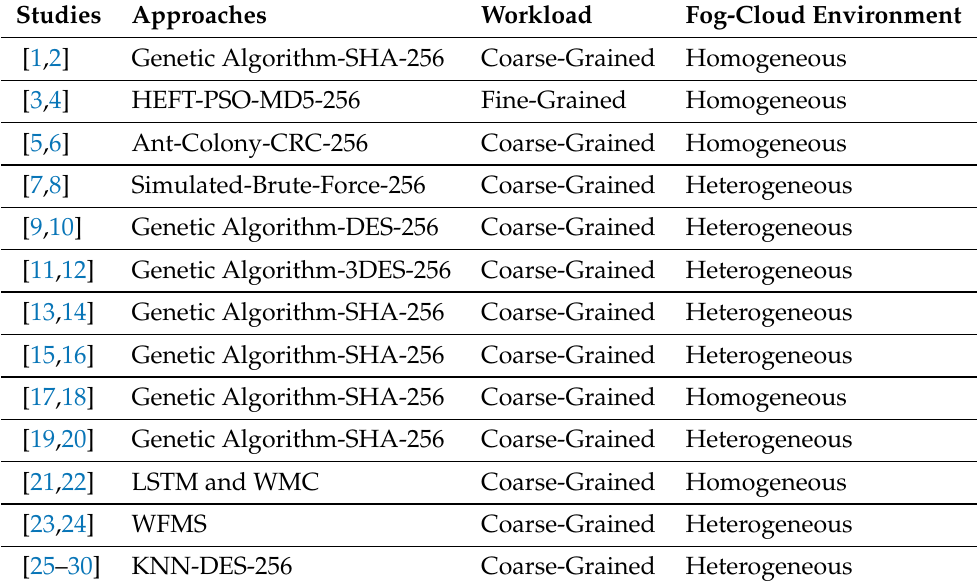
Table 1. Existing Internet of Medical Things approaches in IoT